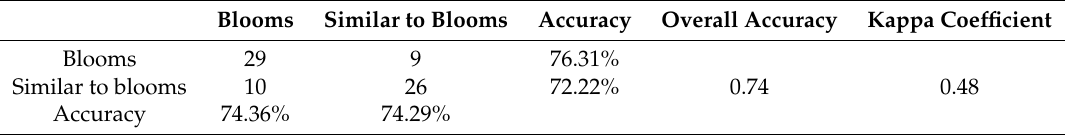
Table 5. Confusion matrix for recognizing the dark regions of Taihu Lake.